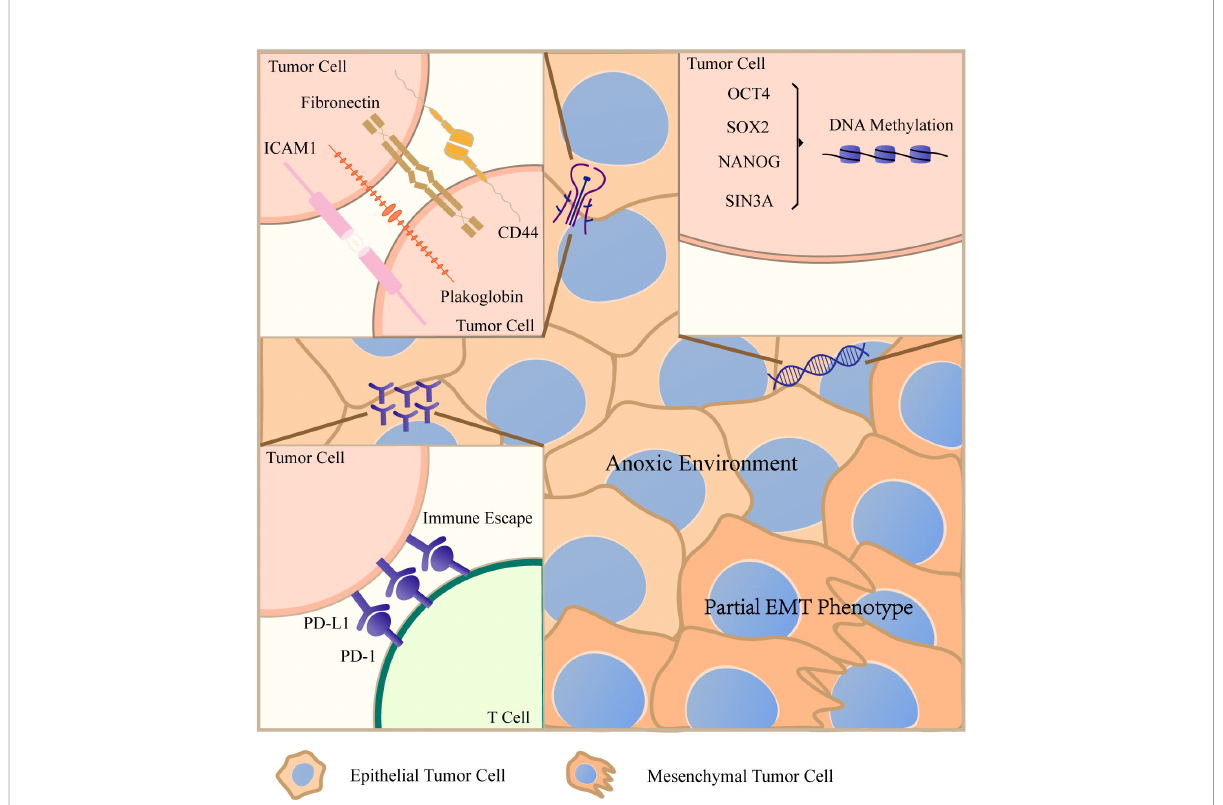
FIGURE 2 Characteristics of homotypic circulating tumor cell (CTC) clusters After CTCs gather into CTCT clusters, they will create favorable living conditions conducive to their own survival in a variety of ways. Cancer cells maintain important intercellular junction molecules, such as CD44, ICAM1, plakoglobin and so on, to resist anoikis. The aggregation of cancer cells can lead to hypomethylation of transcription factor binding sites related to stem cells and proliferation. CTC clusters keep hypoxic environment and the expression of PD – L1 increases signi fi cantly. They evade immune surveillance by these two ways. In addition, CTC clusters have a mixed epithelial/mesenchymal phenotype. When encountering small diameter vessels, they will be arranged in chains. All these characteristics lead to the stronger metastatic ability of CTC